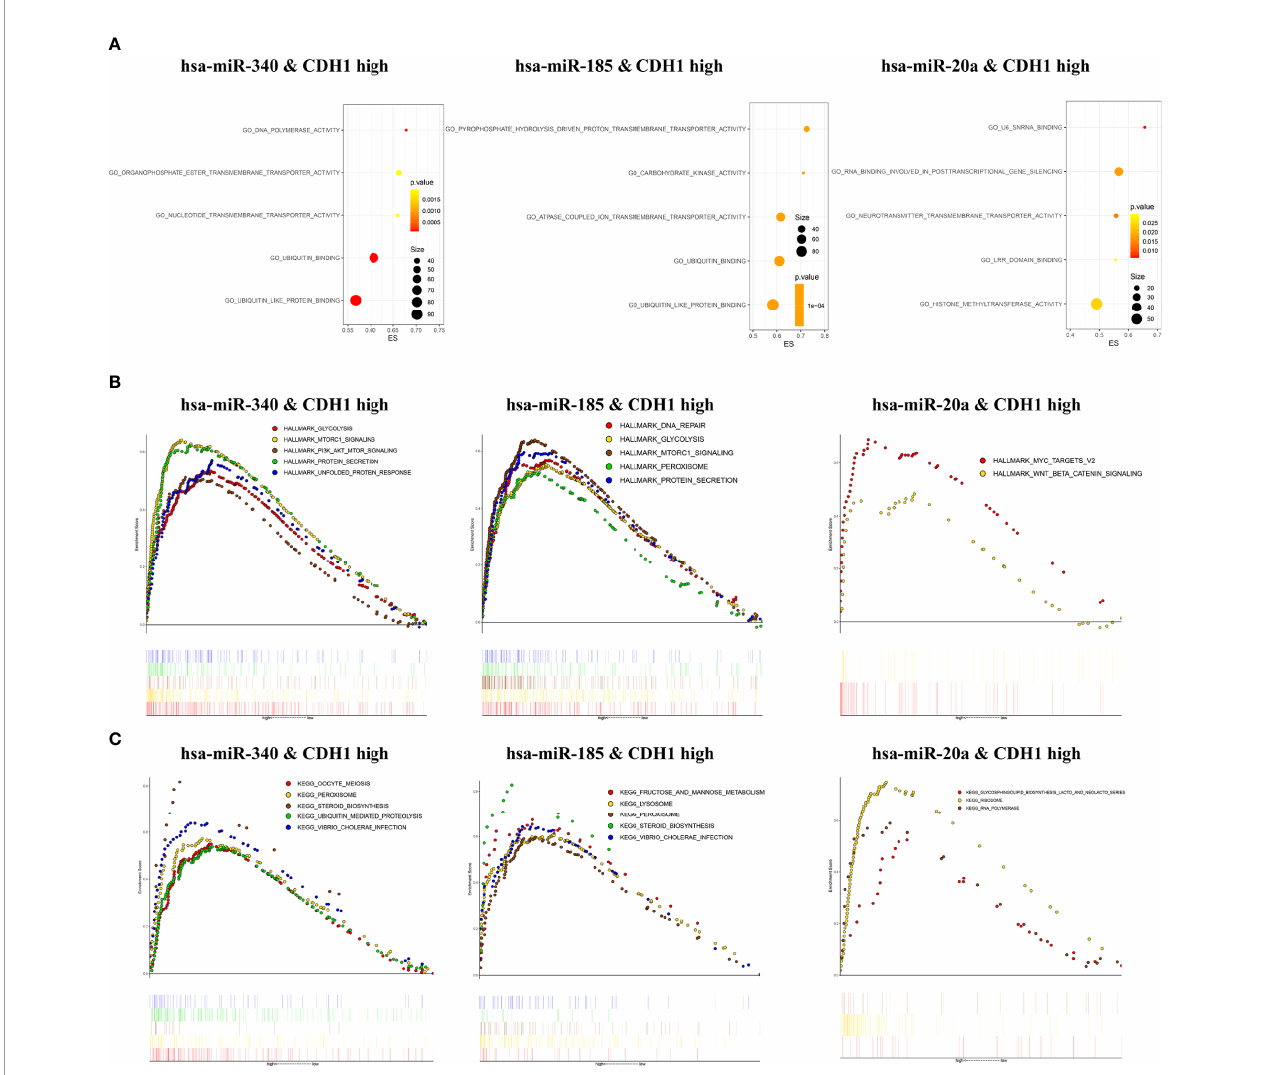
FIGURE 5 | Enrichment analysis of CDH1 in combination with miR-340, miR-185, or miR-20a. (A) Gene Ontology functions enrichment analysis. (B) Hallmark gene set enrichment analysis. (C) KEGG pathways enrichment